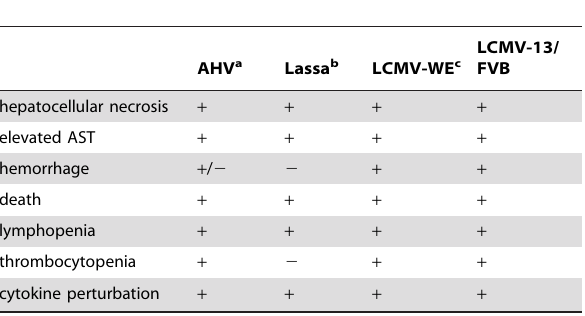
Table 2. Clinical presentation of arenaviral hemorrhagic diseases in comparison to LCMV-13 infected FVB